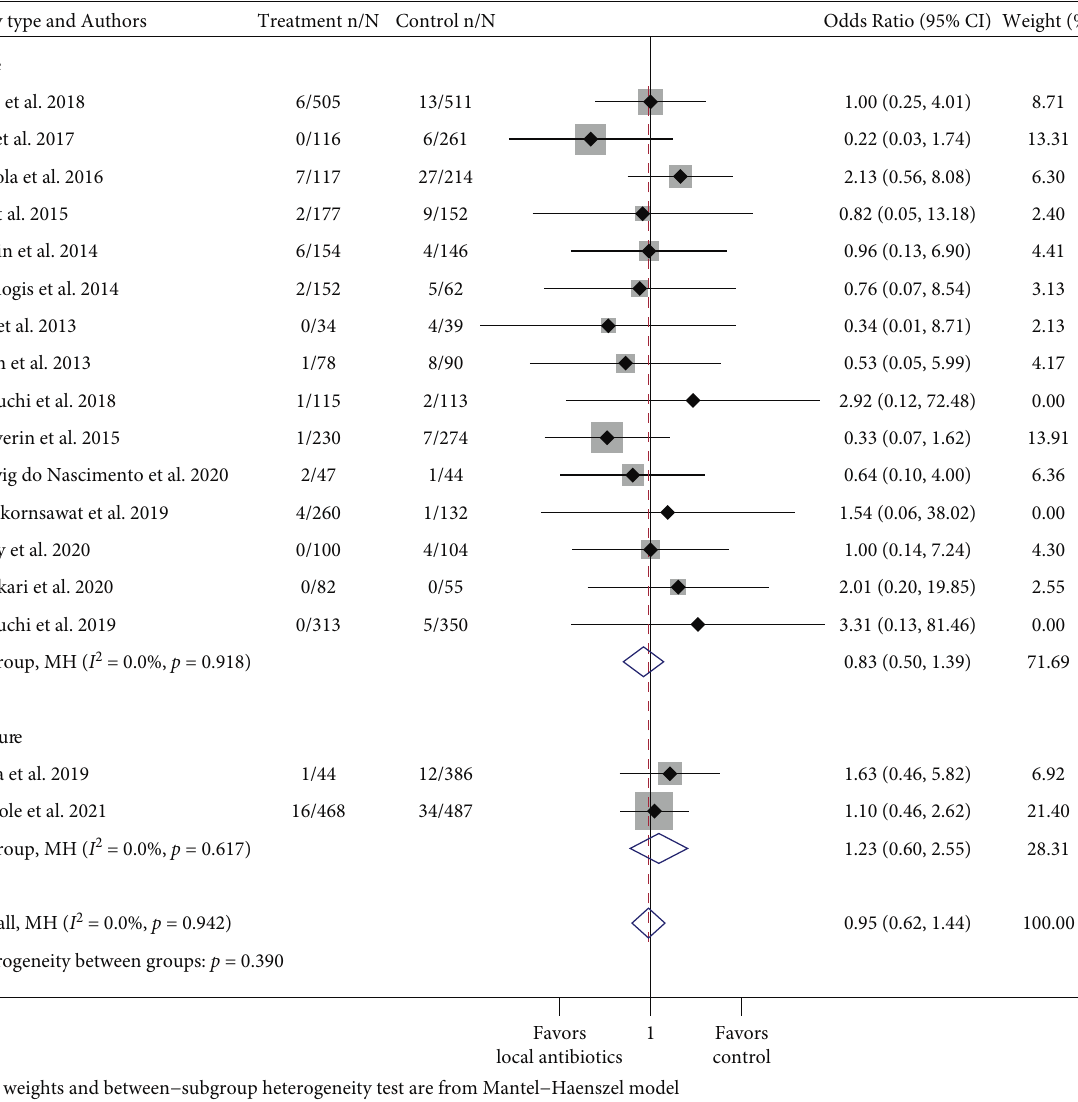
Figure 7: Forest plot of Gram-negative infection data of studies that used vancomycin with subgroup analysis for spine and fracture cases. Treatment n/N: number of infections in the treatment group/total number of patients in the treatment group. Control n/N: number of infections in the control group/total number of patients in the control